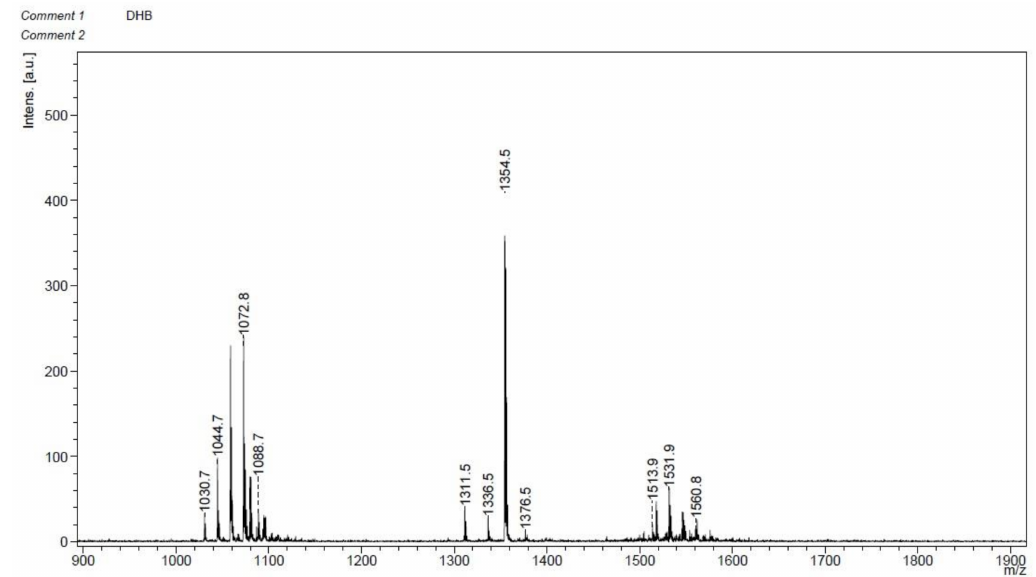
Figure 7. Matrix-assisted laser desorption ionization time-off light (MALDI-TOF) mass spectrometry (MS) spectra of the crude lipopeptide